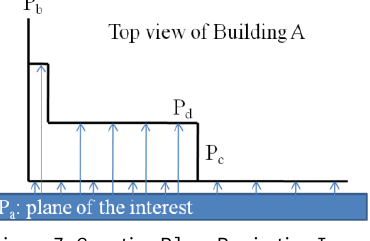
Figure 7. Creating Plane Projection Image